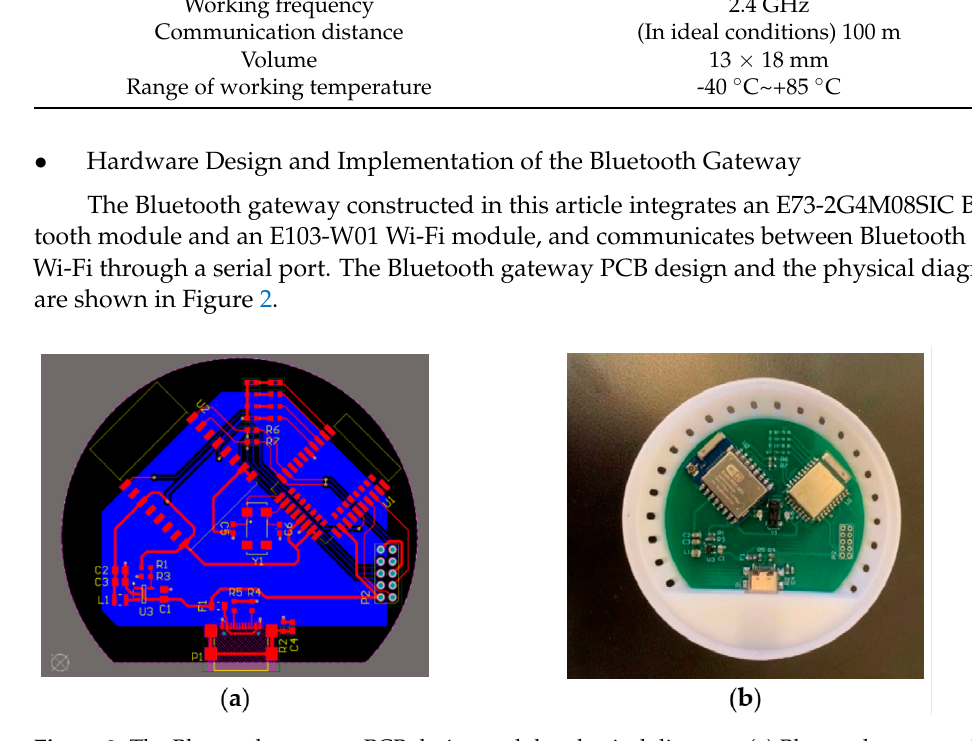
Figure 2. The Bluetooth gateway PCB design and the physical diagram: ( a ) Bluetooth gateway PCB design drawing; ( b ) Bluetooth gateway physical prototype